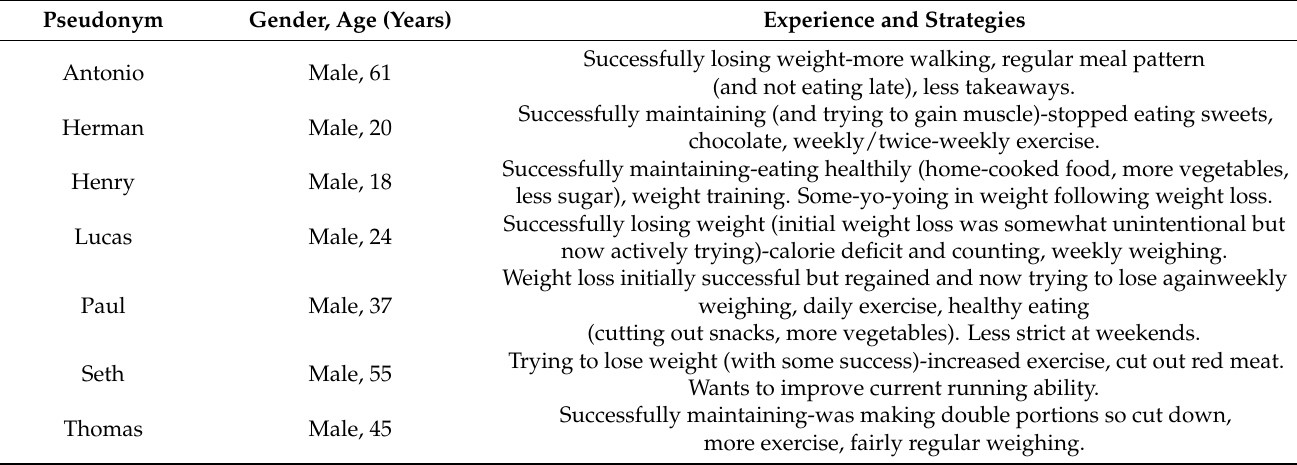
Table 2. Participant